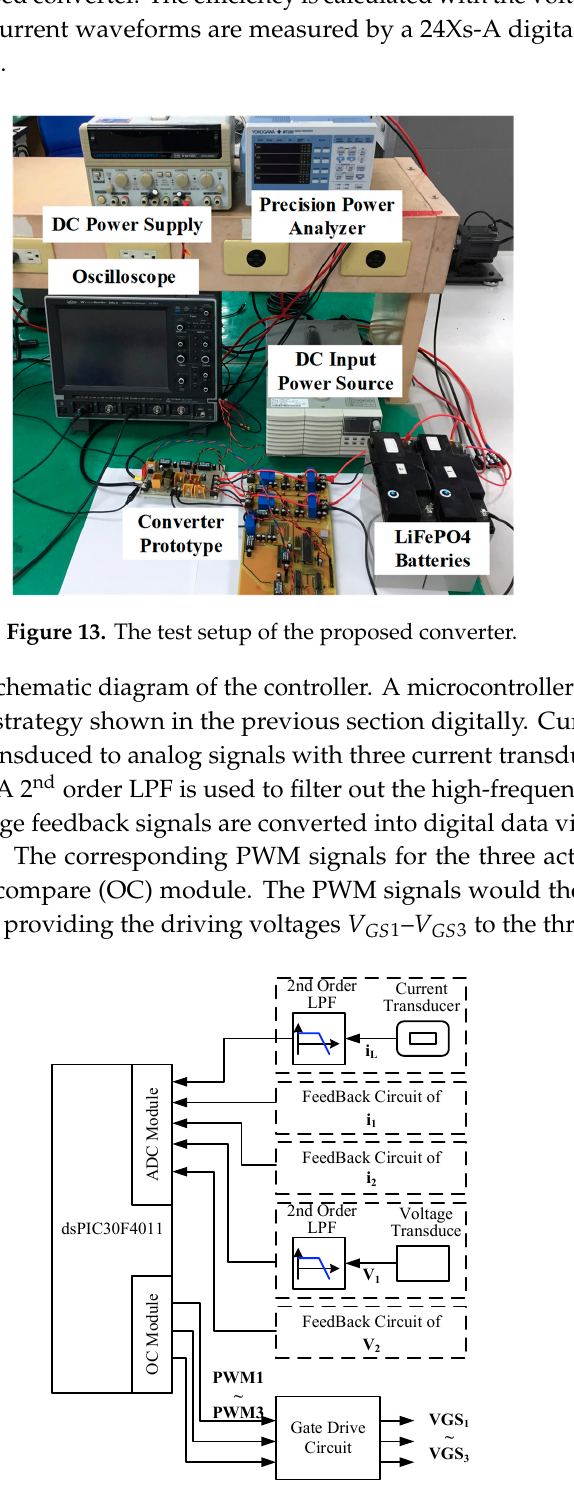
Table 2. Circuit parameters of the constructed prototype.